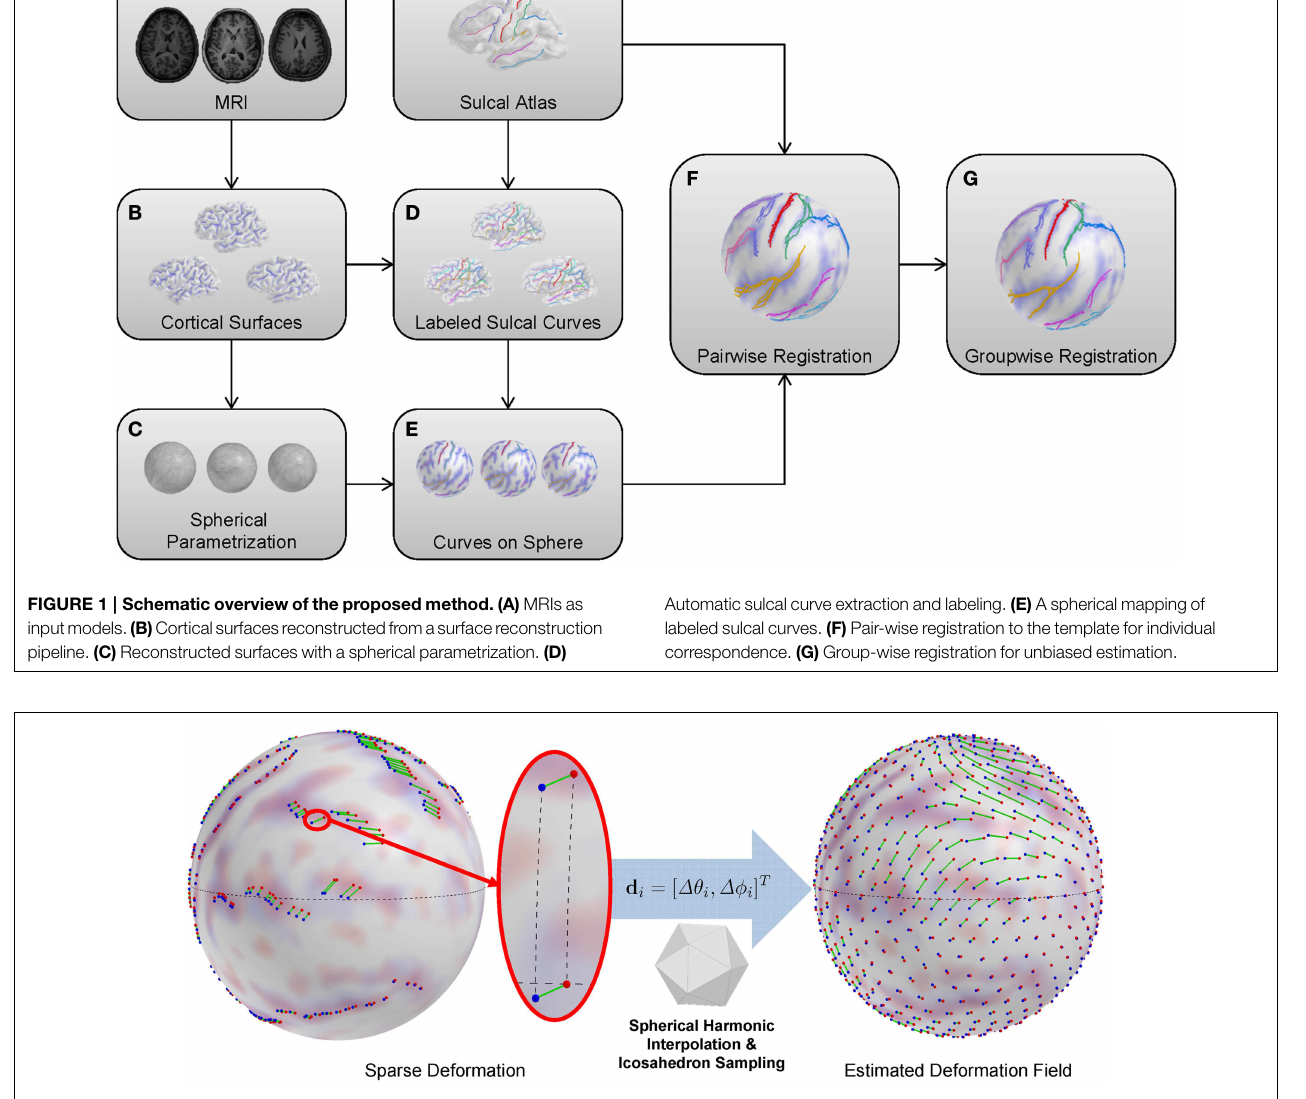
FIGURE 2 | Displacement encoding and estimated deformation field (an icosahedron sampling of continuous representation). A spherical displacement is encoded as change in spherical angles after rotation onto